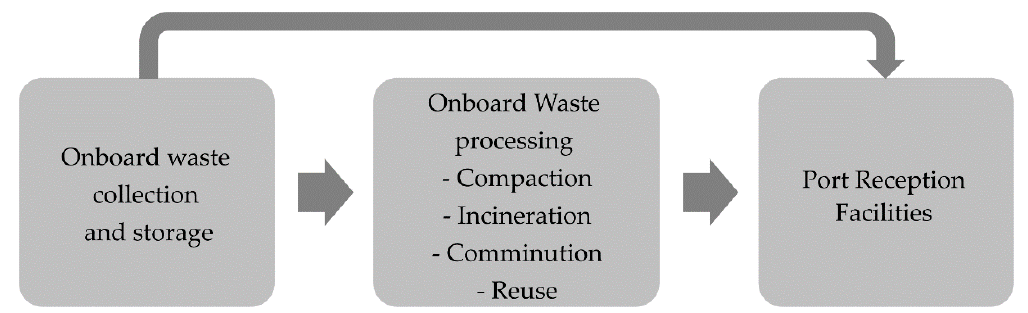
Figure 2. Ship-generated waste processing–waste flow diagram.